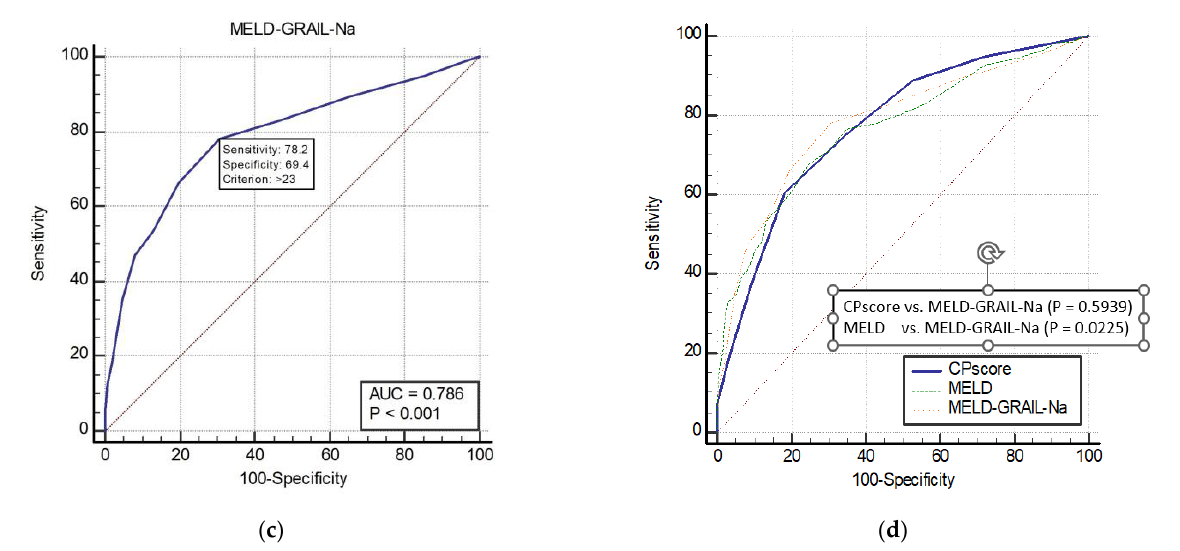
Figure 4. Receiver operating characteristic curves (ROC) and area under the ROC (AUROC) of patients with CP classes B and C for 3-month mortality. ( a ) CP score for 3-month mortality, 0.775 (95% CI, 0.746–0.803); ( b ) MELD for 3 - month mortality, 0.769 (95% CI, 0.739–0.797); ( c ) MELD - GRAIL - Na for 3 - month mortality, 0.786 (95% CI, 0.757–0.813); ( d ) comparison of AUROC for 3 - month mortality between the CP, MELD, and MELD - GRAIL - Na scores.